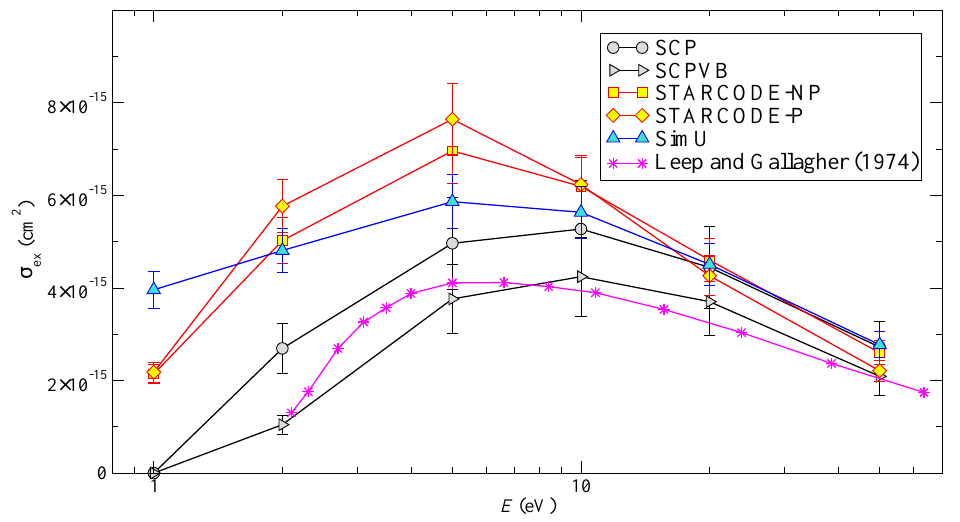
Figure 5. Li I 2 s − 2 p excitation cross-section as a function of the energy E : comparison with experiment